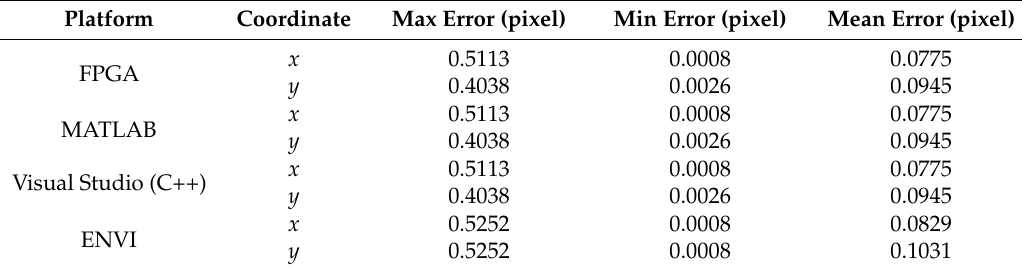
Table 3. The values of root mean square errors ( RMSE s) of the georeferenced image of the first image. Platform